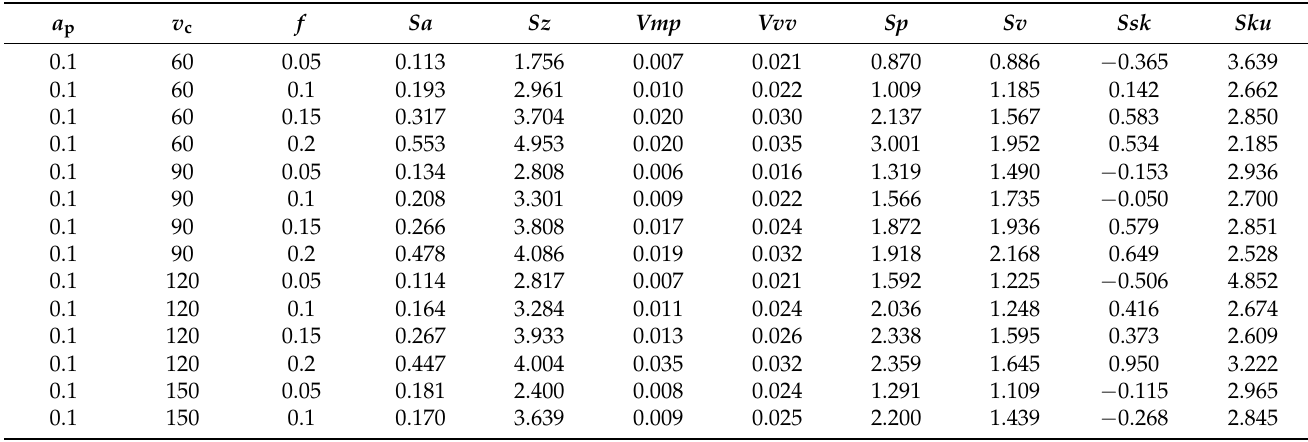
Table A2. Topography parameter data (hard turning, a p = 0.1